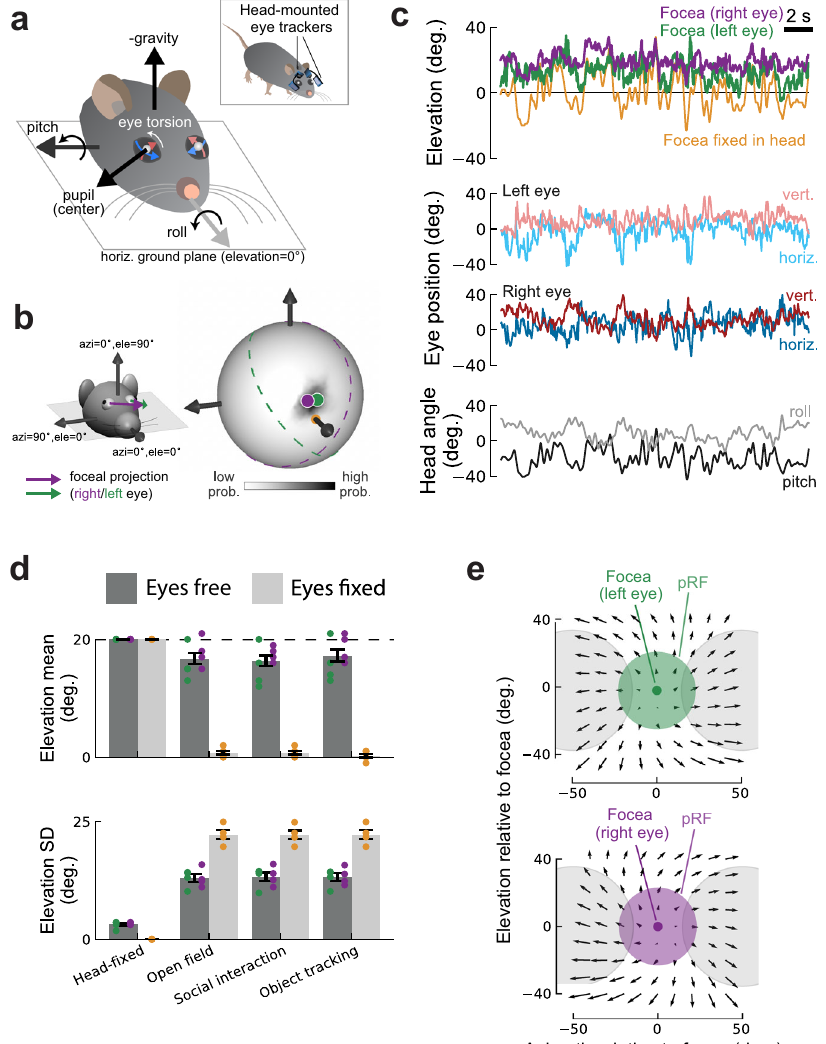
Fig. 8 Compensatory eye movements in freely moving mice keep the focea ahead of the animal. a Tracking of head tilt (pitch and roll) and left and right eye positions in a freely moving mouse (inset). Illustration of head pitch and roll axes (relative to the ground), eye torsion (white arrow), and pupil centers (white dots) in angular eye coordinates (blue and red arrows). b The spherical coordinate system used in this study with [azi = 0°, ele = 0°] pointing toward the animal ’ s nose. The arrows indicate the foceal projection of the right (purple) and left (green) eye. Distribution of angular foceal projections in the same reference frame for an example mouse during spontaneous locomotion in an open fi eld environment (right). Light and dark shading indicate regions of low and high probability, respectively. Dots indicate circular median position of the focea for the left (green) and right (purple) eye. Dashed lines indicate monocular visual fi elds for the left and right eyes (same color schema; 180° visual collection angle for each eye) showing that the focea fell into the binocular zone. c Thirty-second segment showing elevation of left/right foceas (top), horizontal, and vertical eye position of left and right eye (middle) and head pitch and roll (bottom) for the example mouse in ( b ). Same conventions as in ( a ). Control condition ( “ Focea fi xed in head ” ) in top panel shows what the elevation of the focea would have been in the absence of stabilizing eye movements. d Average circular mean elevation (top) and standard deviation (SD, bottom) of the left/right foceas for the same mice either head- fi xed or in three different head-free contexts (open fi eld, social interaction, object tracking). In all three contexts, eye movements counteracted head movements to stabilize the elevation of the focea relative to the ground. Same color schema as in panels a – c . Dark gray bars show means for the focea and light gray bars show means for the control condition ( “ Focea fi xed in head ” in panels a – c ). Means computed across eyes and mice. Data from four mice. Mean ± SEM. e Optical fl ow fi eld during locomotion (body speed >10 cm/s) for the left (top) and right (bottom) eye. Optical fl ow vectors were computed for discrete grid points (spacing 10°) centered at the focea using head and eye positions and the geometry of the environment. Black arrows show average fl ow vectors across four mice. Green/purple shaded circles illustrate pRF size at the focea. Gray circles, pRF size at an azimuth of dimensional Gaussian envelop of the form: ð 1 Þ ð a (cid:2) a 0 Þ 2 þð e (cid:2) e 0 Þ 2 ð 2 Þ G ð a 0 ; e 0 ; σ ; a ; e Þ (cid:3) e (cid:2) 2 σ 2 Wide- fi eld pRF analysis . The parameters of the best- fi tting pRF for each pixel The three free parameters were a 0 and e 0 : the center of the Gaussian in the were estimated using a linear model. The pRF is assumed to take the form of a two- azimuth and elevation directions and σ , the standard deviation of the Gaussian,